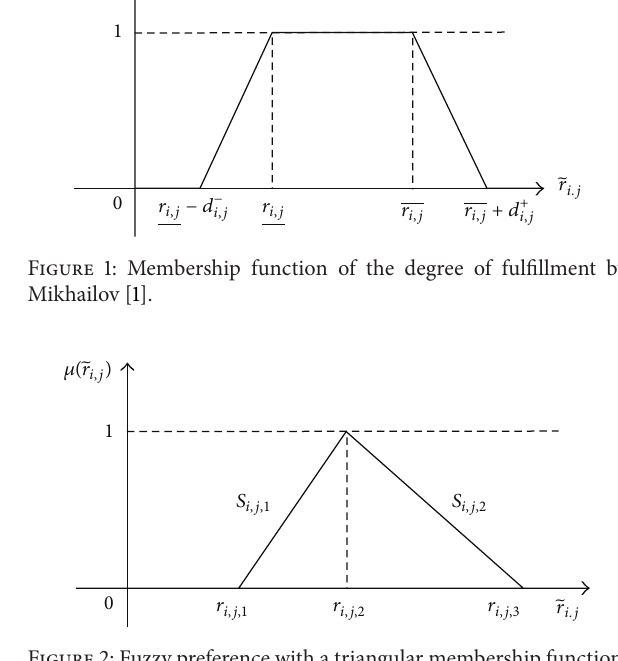
Figure 2: Fuzzy preference with a triangular membership